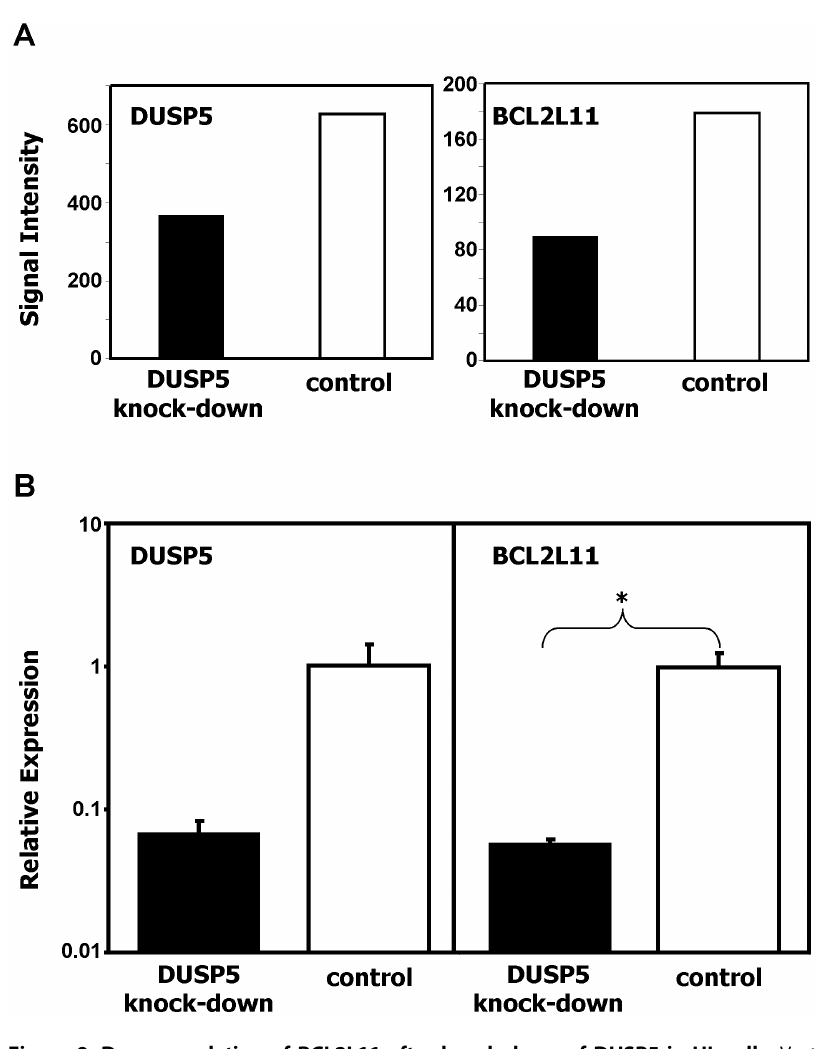
Figure 9. Down-regulation of BCL2L11 after knock-down of DUSP5 in HL cells. Vector based knock-down of DUSP5 in L-428 cells was performed by using the BLOCK-iT POL II miR RNAi expression vector kit as described in Materials and Methods. Gene expression in cells after knock- down of DUSP5 and control cells was analyzed by microarray analysis and quantitative RT-PCR. (A) Results from the microarray analysis. Presented are signal intensities from probe sets corresponding to DUSP5 and BCL2L11 in L-428 cells after knock-down of DUSP5 or after transfection with control vector. (B) Results from RT-PCR analysis. Presented are means and standard deviations from triplicate determinations. For calculation of relative expression values, GAPDH was used as housekeeping control and the median D ct value from control cells was set as 1. Asterisk indicate statistical significance (p , 0.05; Student’s t-test).